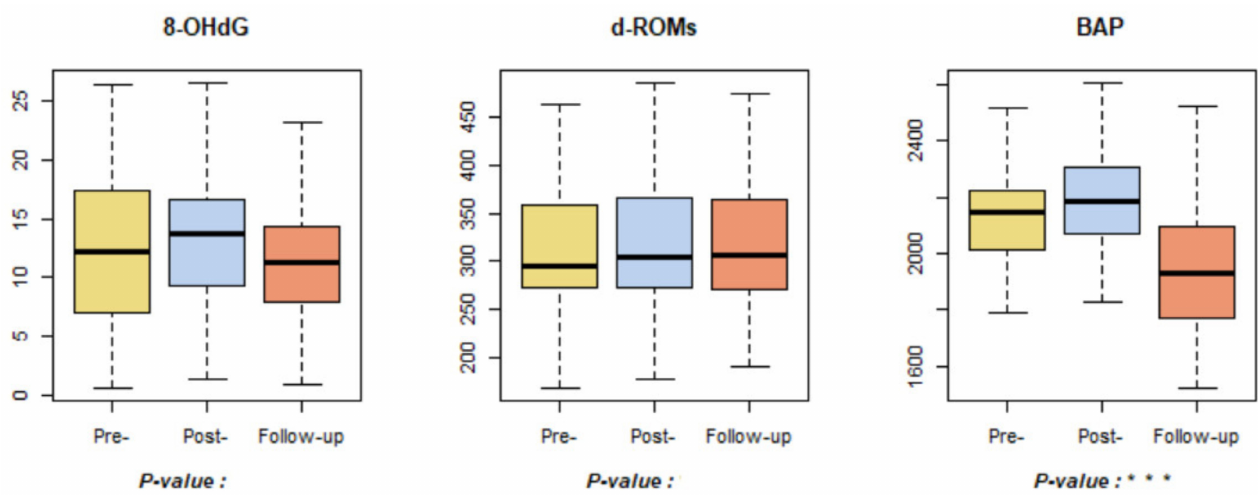
Figure 7. Results of oxidative stress and antioxidant-related indicators. *** p < 0.001. Pre-: daily health conditions 2 weeks prior to the forest healing program; Post-: health conditions immediately after the forest healing program; Follow-up: daily health conditions one, two, and four weeks after the forest healing program; 8-OHdG: 8-hydroxy-2-deoxyguanosine; d-ROMs: derivatives of reactive oxygen metabolites; BAP: biological antioxidant